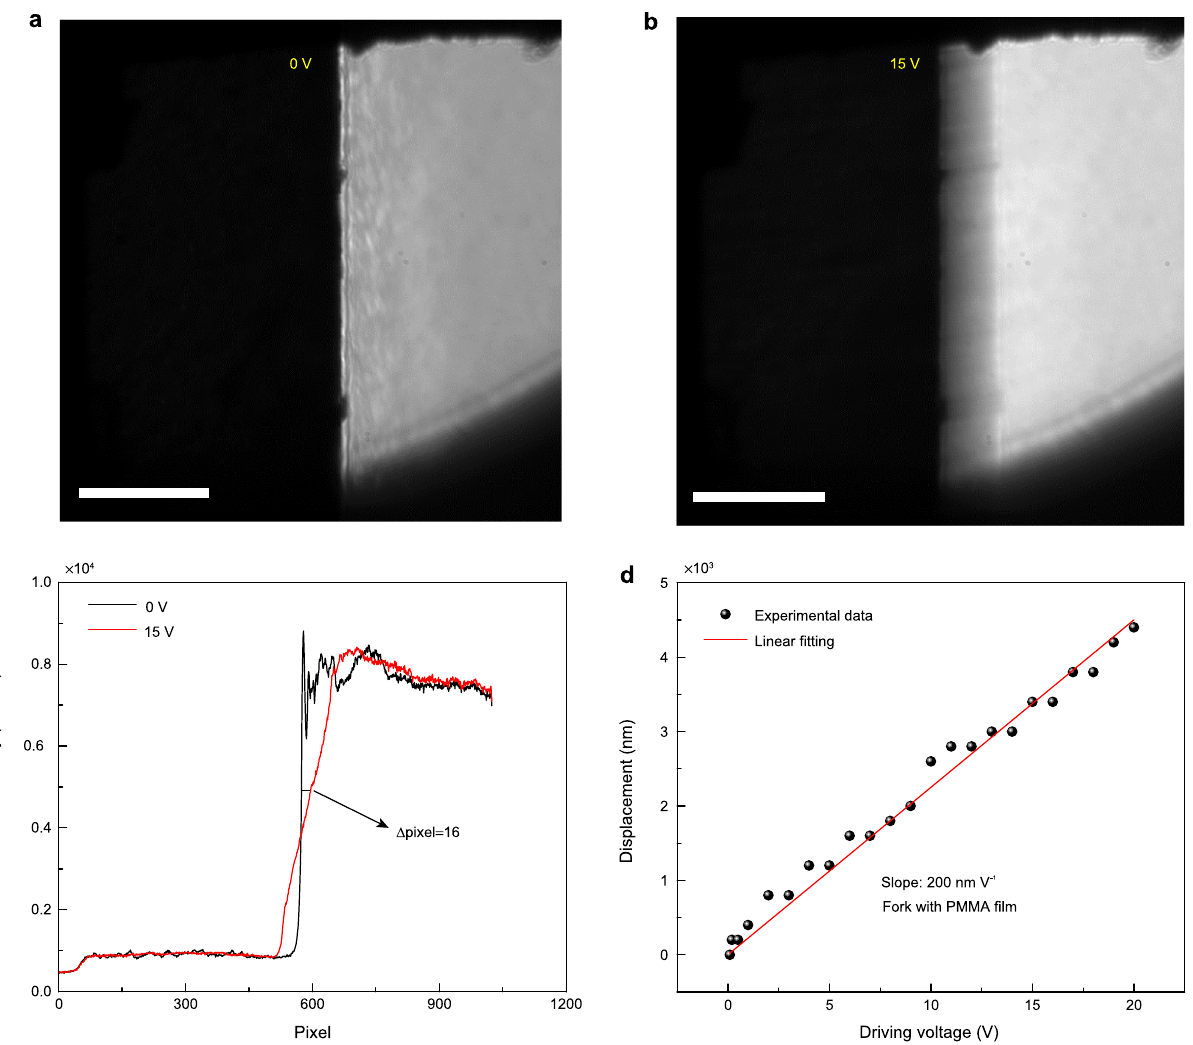
Fig. 3 Characterization of the displacement of the tuning fork as a function of the driving voltage. a Bright- fi eld image of the tuning fork prong in the absence of a driving voltage; Scale bar: 50 μ m. b Bright- fi eld image of the tuning fork prong when driven on resonance with a driving voltage of 15 V. Scale bar: 50 μ m . c The cross-section perpendicular to the edge of the tuning fork prong. The displacement of the tuning fork is ∼ 16 pixels at a driving voltage of 15 V. d Displacement of the tuning fork as a function of the driving voltage at a resonant frequency of 32.717 kHz. The displacement is linearly proportional to the driving voltage. The red solid line is the linear fi tting of the experimental data (solid scattered points) with a slope of ∼ 200 nm V − 1